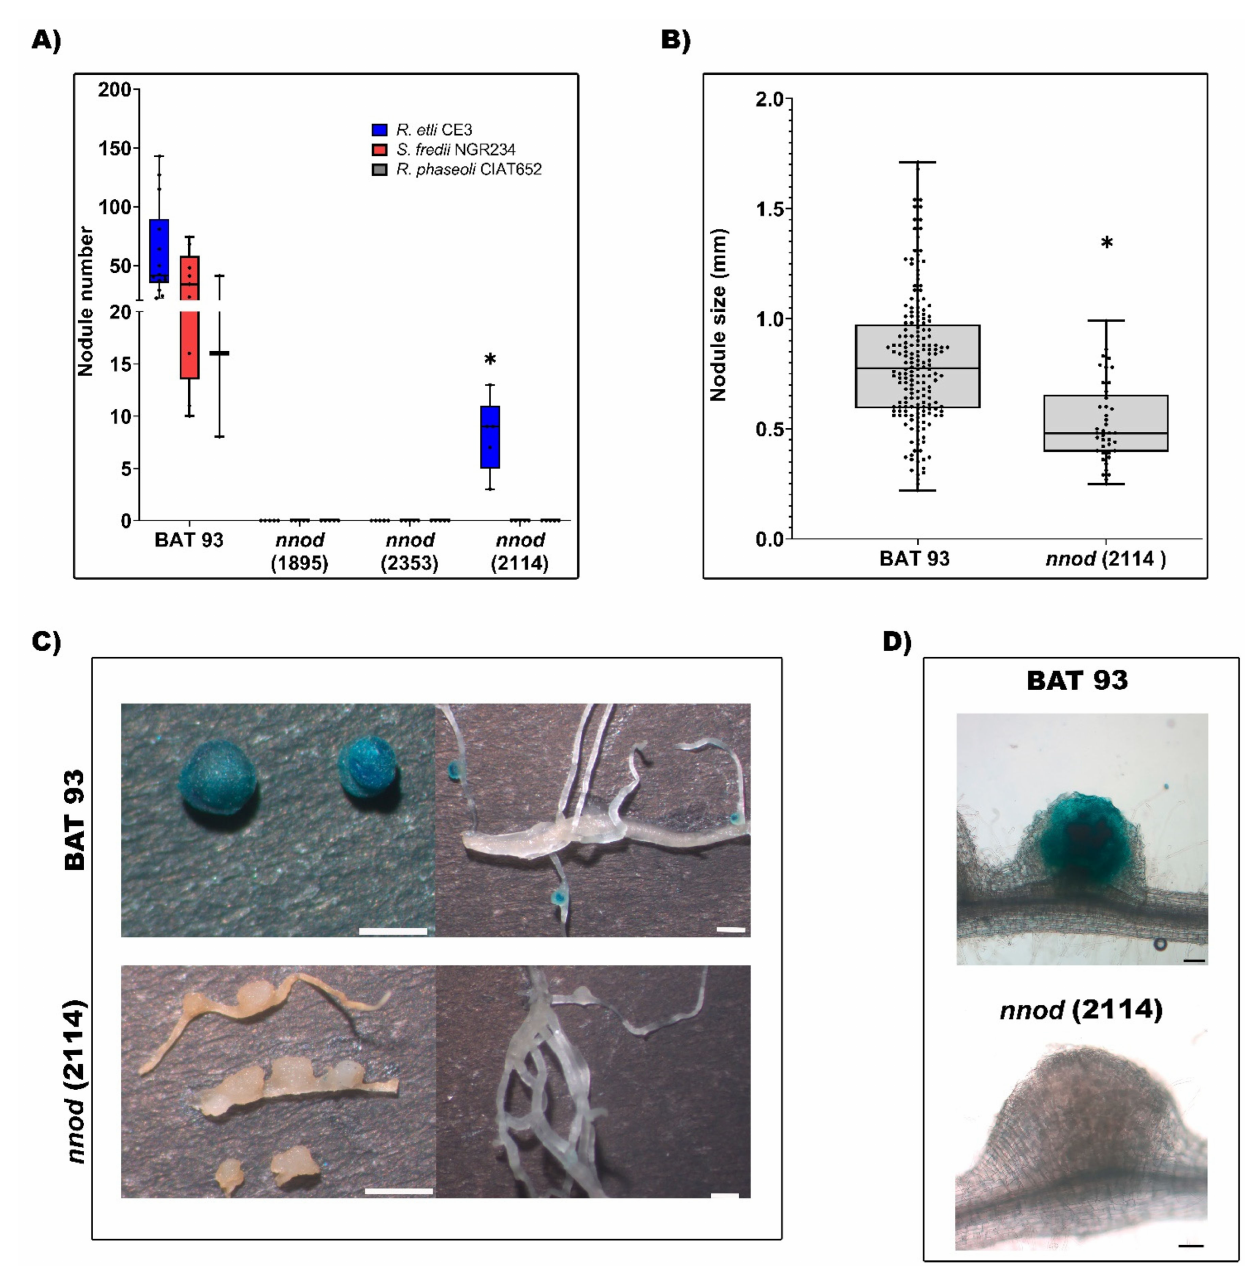
Figure 3. Nodulation phenotype of WT and nnod mutants. Analyses were conducted at 25 dpi. ( A ) Quantification of nodules formed in WT or nnod mutants inoculated with R. etli CE3, Sinorhizobium fredii NGR234 or Rhizobium phaseoli CIAT652 strains. ( B ) Evaluation of the perimeter of nodules formed in WT and nnod (2114) plants inoculated with R. etli CE3 in each genotype. Nodule number and size data ( A , B ) were obtained from at least 10 individual plants. In box plots, horizontal box side represents the first and third quartile, while the outside whiskers represent the minimum and maximal values. ( C , D ) Colonization of R. etli CE3/pGUS in nodules of WT or nnod (2114), visualized after GUS staining. C. Bar = 1 mm. D. Bar = 100 µ m. (*) significant difference ( p ≤ 0.1, Student’s t